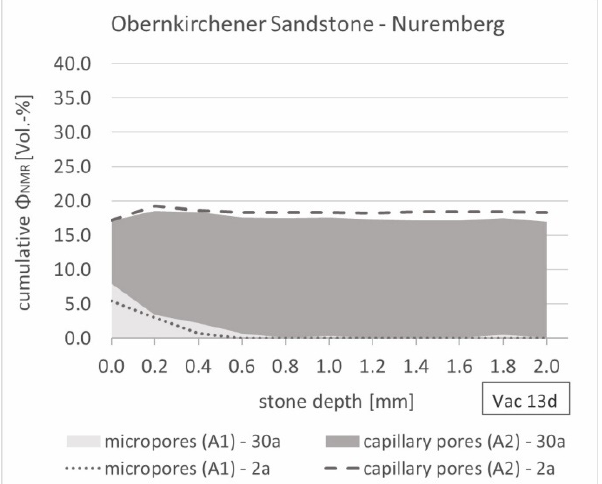
Figure 11. Fitted and stacked relaxation depth profile of the 2- and 30-year weathered Obernkirchener Sandstone samples (exposure site: Nuremberg) saturated under vacuum (0.05 bar).